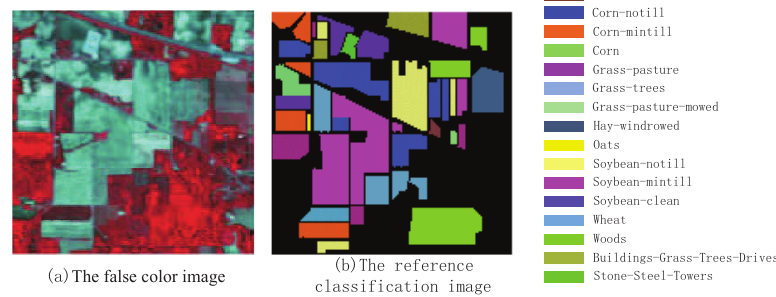
Figure 3. The schematic diagram of AVIRIS